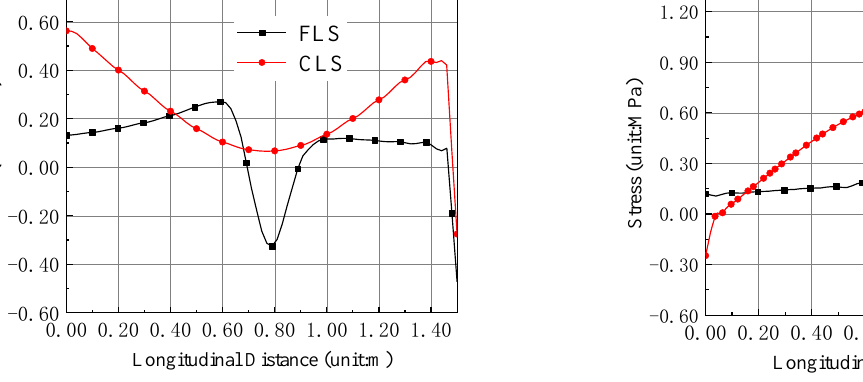
Figure 10. Stress distribution on link-slab under vehicle braking force on the right span.